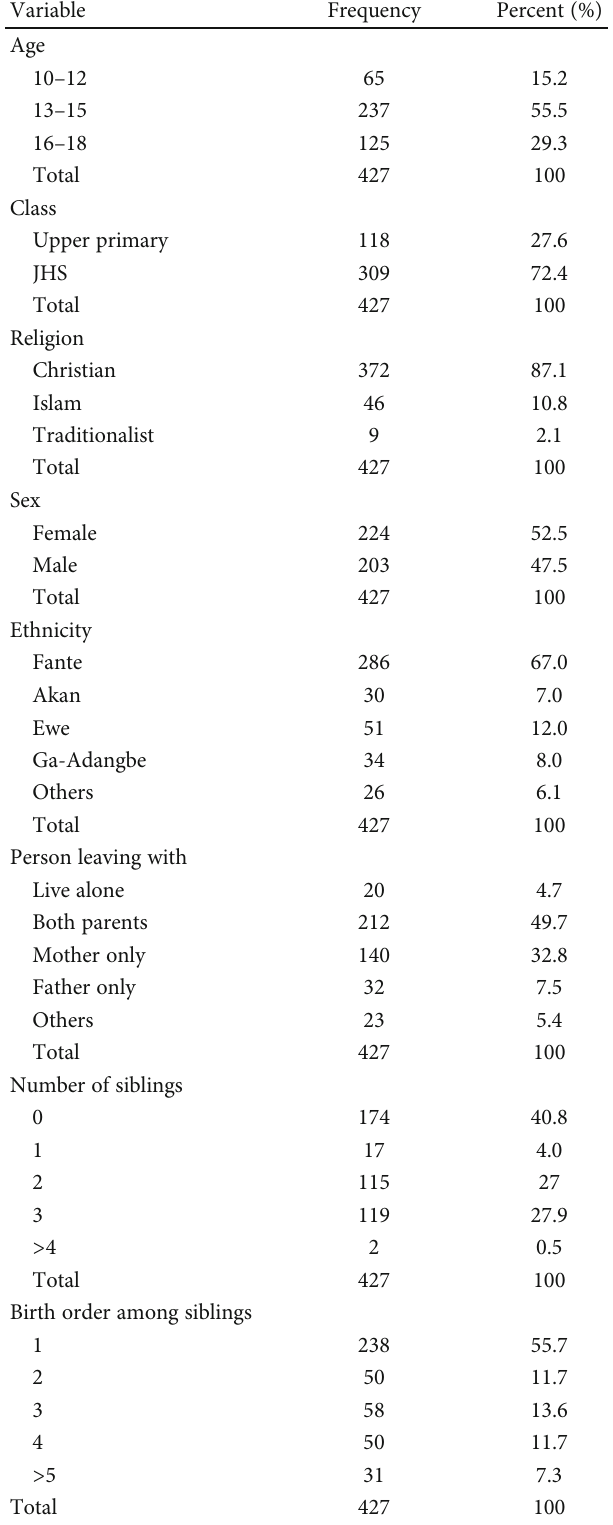
Table 1: Background characteristics of